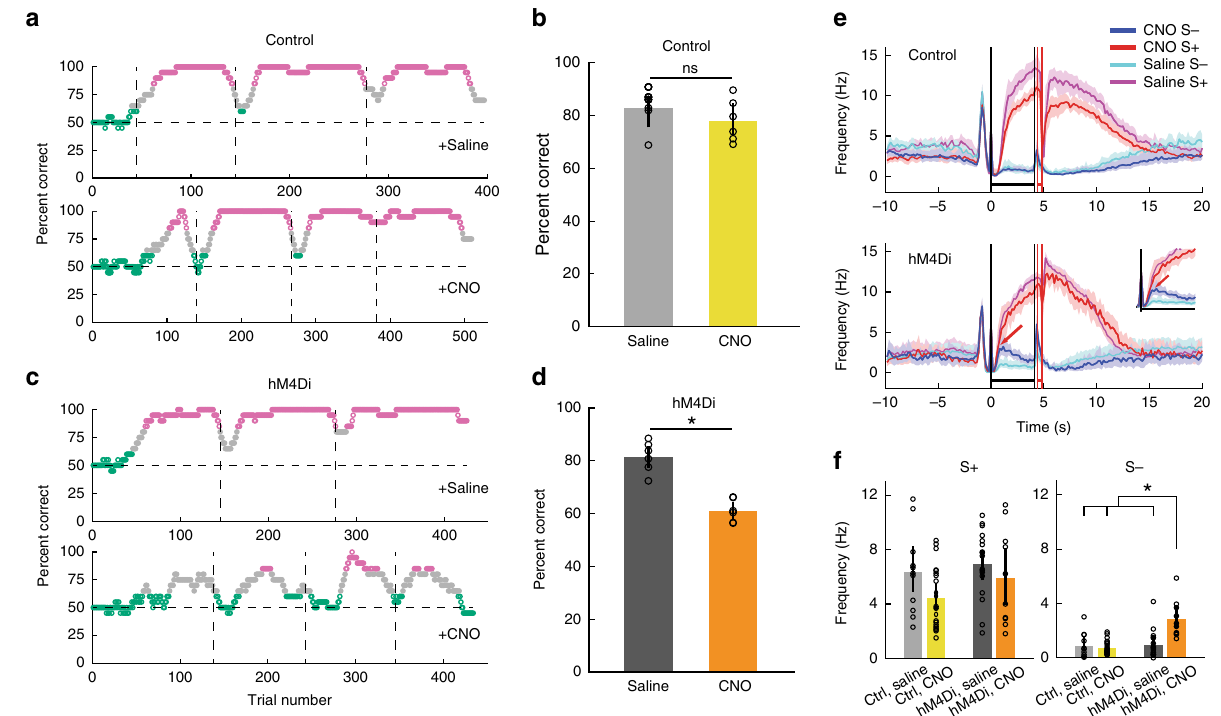
Fig. 7 Chemogenetic inhibition of MLI activity impairs associative learning. a , c Examples of behavioral performance in a go – no go task where mice learned to differentiate between two odorant mixtures (S + : 0.1% of 60% heptanal + 40% ethyl butyrate, S − : 0.1% of 40% heptanal + 60% ethyl butyrate). Green: ≤ 65% correct, magenta: ≥ 80% correct. The vertical lines are the boundaries between different daily sessions. n = 20 trials within a sliding window. b , d Behavioral performance (mean ± 95% CIs, n = 6). b Mice expressing mCherry in MLIs (control mice). d Mice expressing hM4Di in MLIs. A GLM analysis indicates that there is a statistically signi fi cant interaction between CNO drug treatment and hM4Di expression ( p < 0.01, 24 observations, 20 d.f., n = 6 mice, GLM F-statistic = 13.7, p < 0.001) and post-hoc unpaired two-sided t tests indicate that the hM4Di expressing group differs between CNO and saline (asterisks, p < pFDR = 0.025, n = 12 mice). e Average lick frequency time course for the control (upper panel) and hM4Di (lower panel) groups (mean ± 95% CI, shade). The arrow in the inset shows that for S − trials of CNO treated hM4Di animals (blue), the animal kept licking for a longer time than S − trials for mice injected with saline (cyan). The vertical black lines are odorant onset and removal and the red lines bound the reinforcement period. f Mean lick frequency (±95% CI) during the initial portion of the odorant application period (0.8 – 1.8s) for mice performing ≥ 80% correct (left: S + , right: S − ). GLM analysis did not fi nd a statistically signi fi cant difference for treatment or hM4Di expression (or interactions) for S + ( p > 0.05, 60 observations,